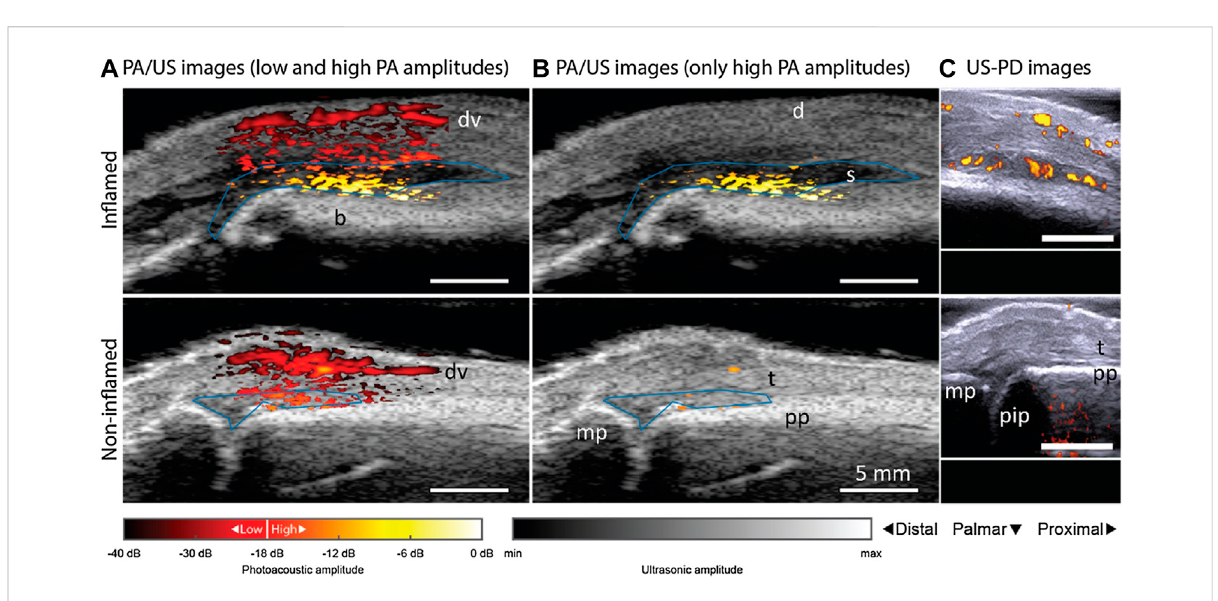
FIGURE 7 PAT/US and US/PD images of an in fl amed contra-lateral (bottom row) and non-in fl amed (upper row) joint from a patient with rheumatoid arthritis.PAT/USimagesin (A) showadifferenceincolorbetweenin fl amedandnon-in fl amedcorrespondingtoanincreaseinamplitudelevels.Iflow PATamplitudesarediscardedin (B) ,onlyfeaturesinthein fl amedjointareseen.Figure (C) showsthecorrespondingUS-PDimages.BluelinesinPAT/ US images indicate ROIs used for PAT feature quanti fi cation in synovial space. The 0 dB level is the maximum PAT amplitude produced by an in fl amed joint. d, dermis; dv, dorsal vein; pp, proximal phalanx; pip, proximally located interphalangeal joint; mp, midline phalanxes; s, synovium; t, extensor tendon; PAT, photoacoustic tomography; US, ultrasound; PD, powered Doppler. Reprinted with permission from [van den Berg P.